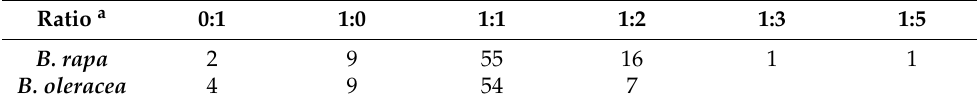
Table 1. The synteny relationship of NPF genes between B. rapa and B. napus , and between B. oleracea and B.